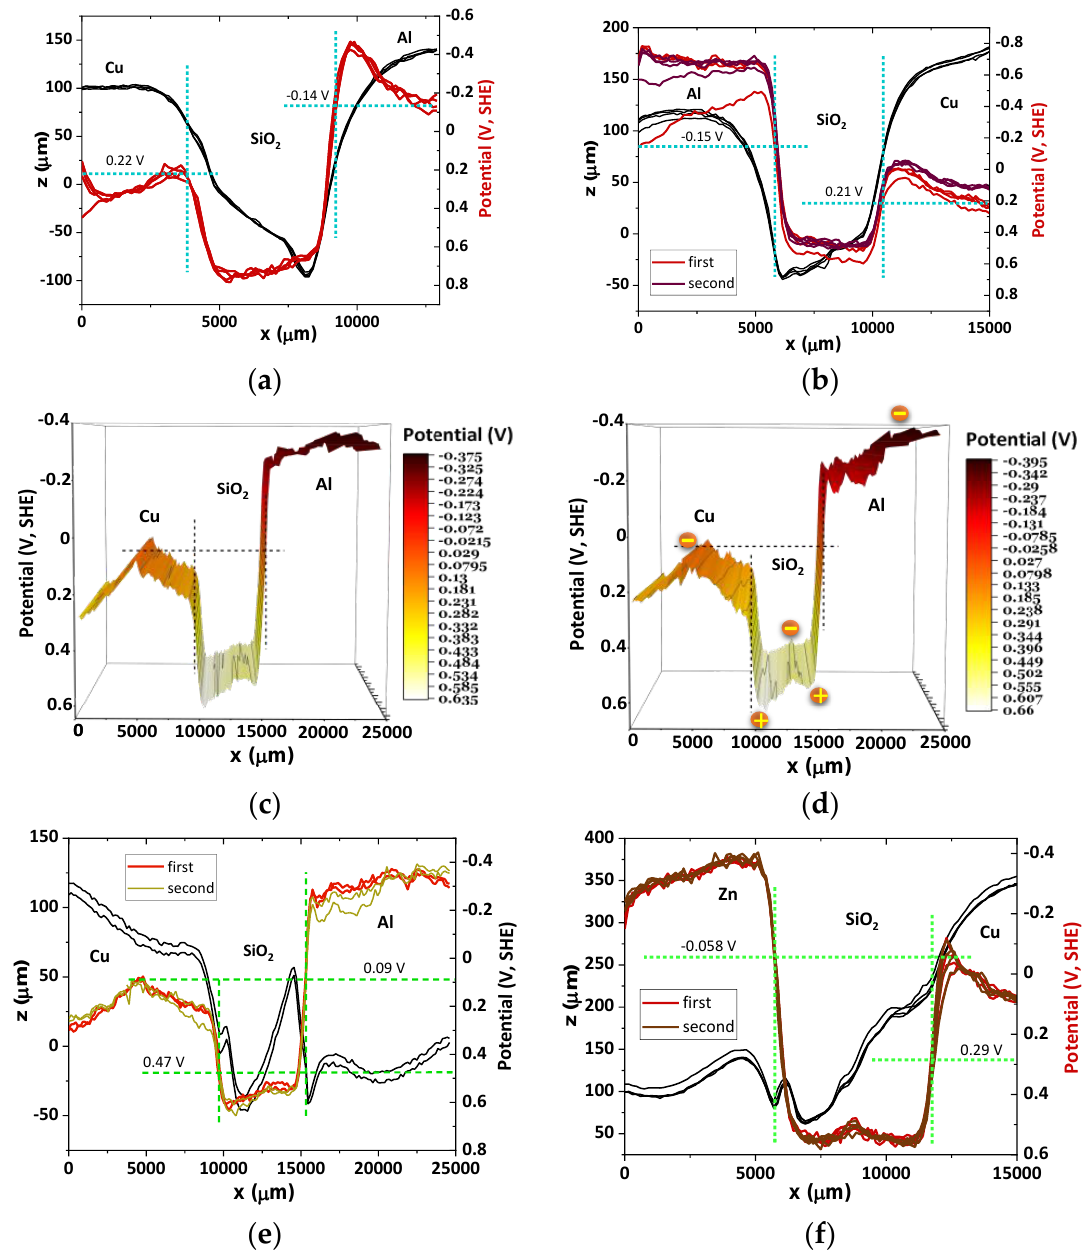
Figure 3. Topography and surface chemical potentials for an Al/SiO 2 /Cu cell show different energies for the equalization of the surface chemical potentials of the heterojunctions Cu/SiO 2 , SiO 2 /Al, Al/SiO 2, and Zn/SiO 2 : ( a ) straight band bending denoted by the SiO 2 surface chemical potential when Cu was connected to the SKP; ( b ) straight band bending denoted by the SiO 2 surface chemical potential when Al is connected to the SKP mirroring ( a ); ( c – e ) extended SKP analysis showing dielectric behavior of surface chemical potential of SiO 2 and a positive–negative–positive polarization distribution on the Cu that transitions almost seemingly to the SiO 2 polarized positive–negative–positive, and, finally, the Al positive-negative; ( f ) Zn/SiO 2 /Cu with positive–negative–positive polarization of the dielectric (SiO 2 ).